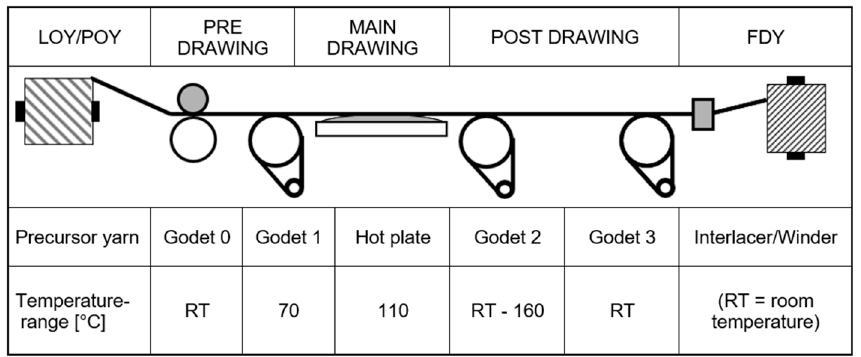
Figure 1. Yarn drawing set-up. LOY: low oriented yarn; POY: partially oriented yarn; FDY: fully drawn yarn.